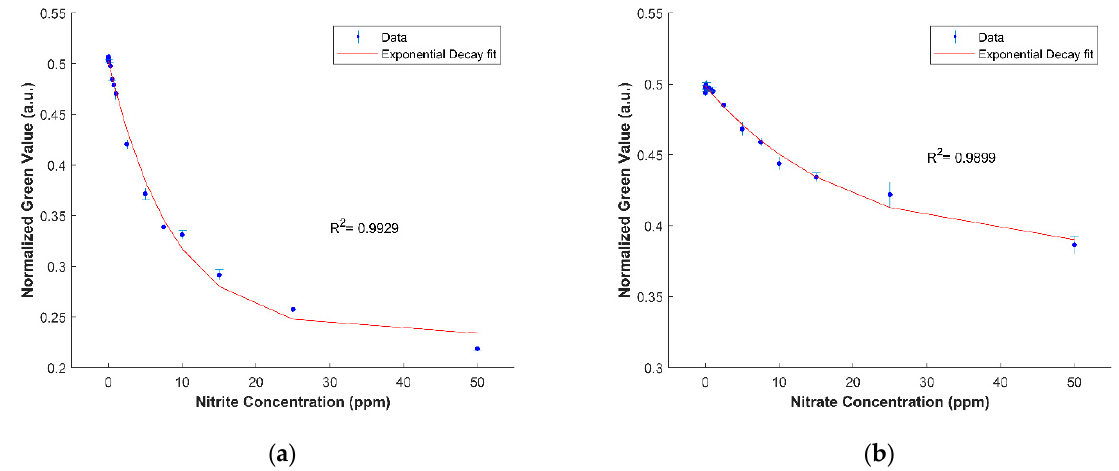
Figure 8. ( a ) An exponential decay calibration curve in the form y = a × exp ( − x/b) + c, where a = 0.1164, b = 18.85, and c = 0.3819 was established for nitrite in Sargasso seawater. ( b ) An exponential decay calibration curve in the form y = a × exp ( − x/b) + c, where a = 0.1164, b = 18.85, and c = 0.3819 was established for nitrate in Sargasso seawater. The error bars represent the standard deviation.